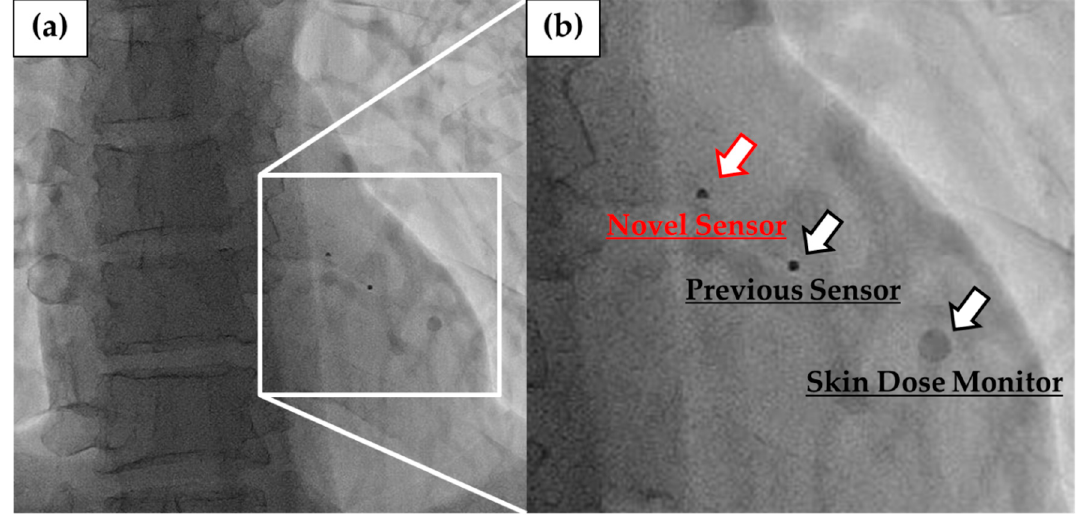
Figure 11. Fluoroscopic image: (a) 3 sensors placed on chest phantom, (b) magnified view of Figure 11(a).